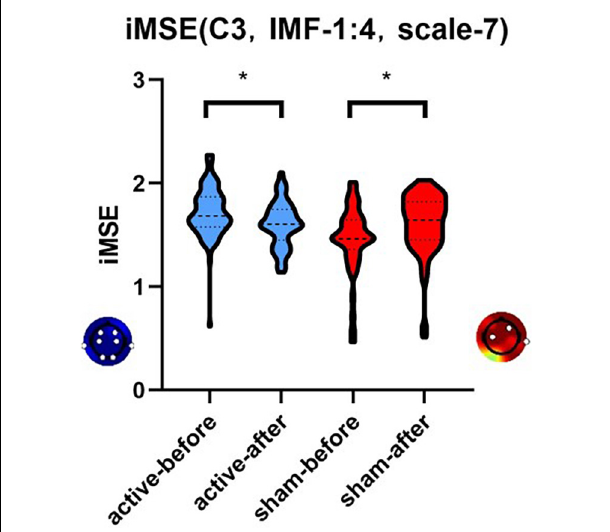
FIGURE 4 | The differences in variation trend of iMSE in the case of channel C3, IMF 1:4, and scale 7. There was a different variation trend in the iMSE between the active and sham groups. “*” means that significant change from baseline (p < 0.05). Red colors represent increased EEG complexity and blue colors represent decreased EEG